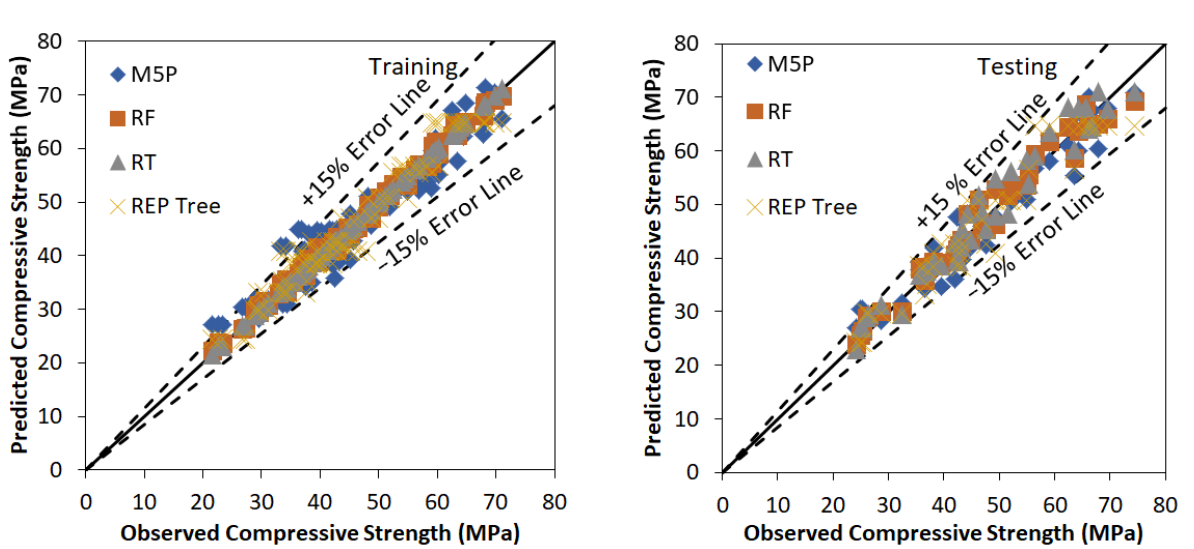
Figure 2. Observed vs. Predicted values using M5P, RF, RT and REP tree based model using training and testing stage.